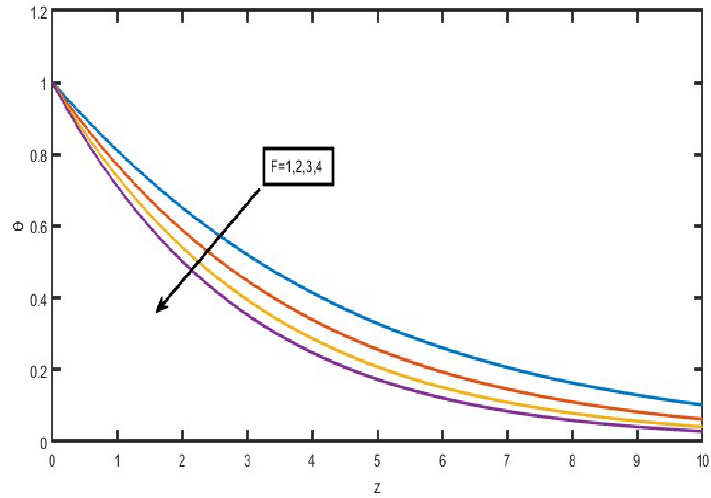
Figure 14. Temperature profiles for Radiation parameter (F).